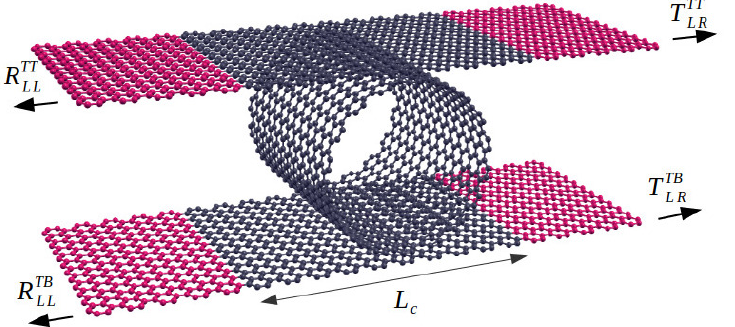
Figure 1. Schematic view of the prototype device discussed here: two N-armchair nanoribbons (top and bottom) with a finite (n,n)-CNT laying in between. The tube is perfectly superposed with ribbons. Gray colors are used to denote the central region (length L c ) and red to define the right/left, top/bottom